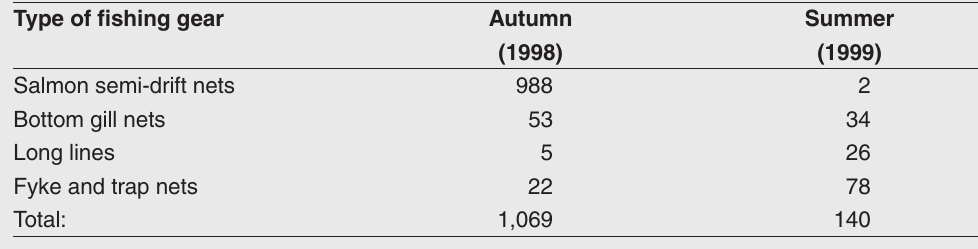
Table 3 . Number of fishing nets and long lines laid out in Puck Bay according to a special observation scheme in 1998 and 1999.